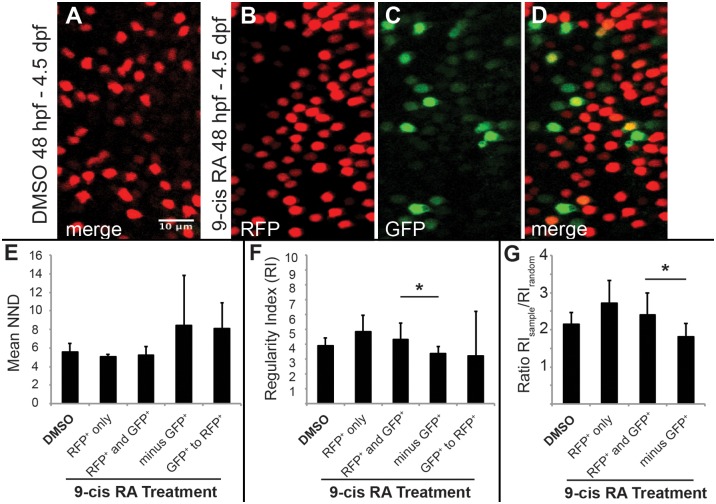
Two-dimensional pattern analysis of LWS cones in LWS:PAC(H) embryos exposed to RA: Retinoic acid induced LWS1-expressing cones do not disrupt the LWS2 cone mosaic.Regions from confocal images at 60X magnification obtained from whole mounted LWS:PAC(H) eyes treated with DMSO or 0.3 μM 9-cis RA 48 hpf to 4.5 dpf were used for pattern analysis. A-D. Representative regions used to determine the mean nearest neighbor distance (NND) and Regularity Index (RI) of LWS cones in control and 9-cis RA-treated eyes. Regions from DMSO treated retinas expressed only LWS2:RFP cones (red) (A), while regions from 9-cis RA treated retinas (B-D) contained RFP+ (red), GFP+ (green), and RFP+/GFP+ (yellow) cones. B-D. Images showing RFP signal only (B), GFP signal only (C), and merge of both signals (D) in regions of 9-cis RA treated retina. Graphs of NND (E, left three bars) and RI (F, left three bars) corresponding to regions from DMSO treated (DMSO) and 9-cis RA treated retinas. 9-cis RA treated retinas were further divided into groups: regions of retina where only RFP+ cones are present (RFP+ only), and regions containing both RFP+ and GFP+ cones (RFP+ and GFP+) when all labeled cells (regardless of RFP or GFP expression) are treated as the same cell type. Graphs also indicate NND (E, right two bars) and RI (F, right two bars) for 9-cis RA treated retinas when GFP+ cones are subtracted from the RFP+ and GFP+ mosaic (minus GFP+) and when the pattern of GFP+ cones to RFP+ cones (GFP+ to RFP+) is analyzed. G. Graph showing the ratio of RI from each indicated region (RIsample) with that of the average RI from 1000 generated random samples of the same number of cells (RIrandom). The asterisk (*) in F and G indicates p<0.05 for a two-tailed Student’s t-test between the indicated groups. Error bars represent standard deviation (n = 7 regions from 4 eyes, DMSO; 6 regions of RFP+ only and 10 regions RFP+ and GFP+ from 6 eyes, RA).